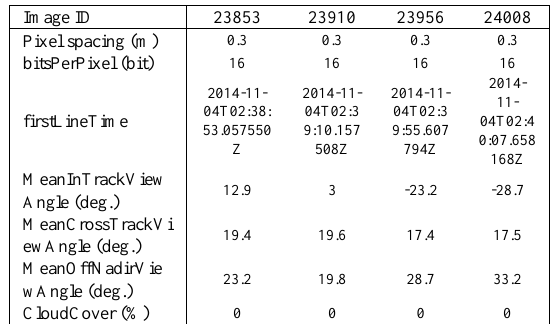
Figure 3. The overlapping rate inside each stereo-pair approaches 100%, while between the two stereo-pairs there is an abundant overlapping area in cross-track direction.